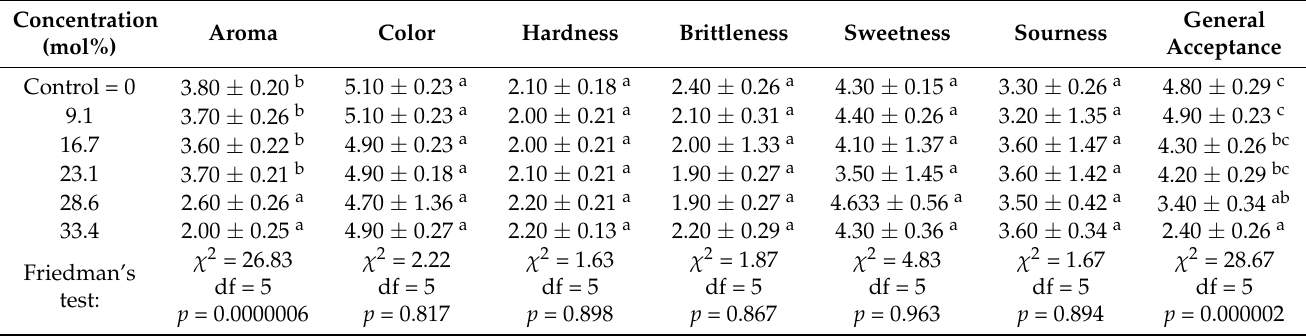
Table 3. Mean panelists ranking scores of the sensory properties of the dried apricot treated with different concentration of CO 2 .